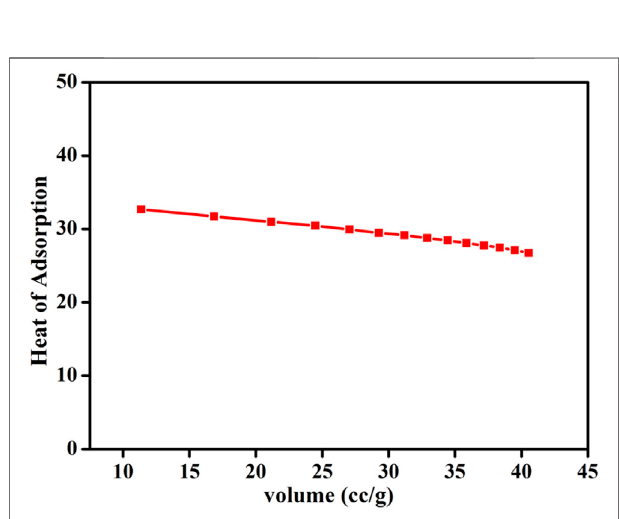
FIGURE 4 | Isosteric heat of the adsorption curve of HMP-TAPA for CO 2 .